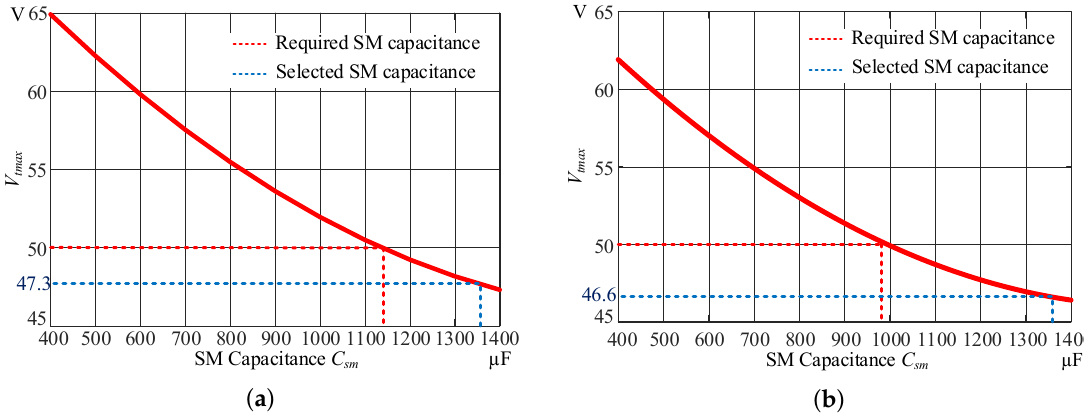
Figure 9. The maximum SM voltage under different grid faults: ( a ) single-line-to-ground condition and ( b ) three-phase short-circuit condition. Table 2. System parameters and design